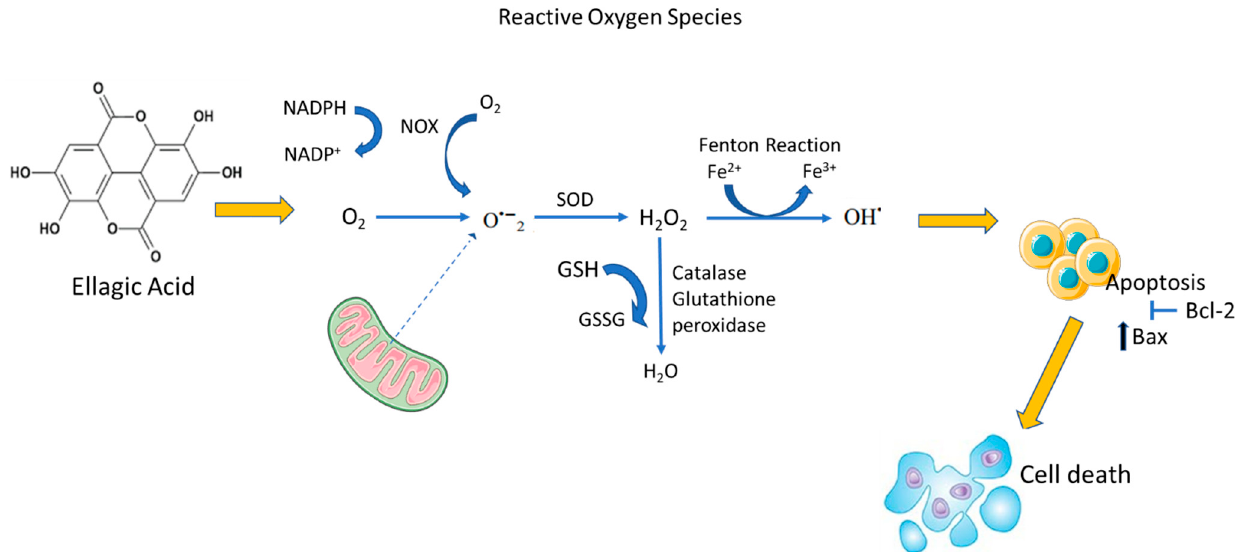
Figure 3. Mechanism of action of ellagic acid from P. granatum extract on MCF-7 breast cancer cells. Superoxide dismutase (SOD), oxidase enzyme (NOX), molecular oxygen (O 2 ), glutathione (GSH), oxidized glutathione (GSSG), hydrogen peroxide (H 2 O 2 ), superoxide anion (O 2 • − ), hydroxyl ion (OH•), NADPH (nicotinamide adenine dinucleotide phosphate), nicotinamide adenine dinucleotide phosphate coenzyme (NADP + ), ferrous cation (Fe 2+ ), ferric cation (Fe 3+ ), and water (H 2 O). The anticancer components of P. granatum are polyphenols, specifically ellagitannins (ET), flavonoids, punicalagin, to mention a few. The ET metabolize into active compounds named urolithin A (UA) and ellagic acid through the gut microbiota [9]. The